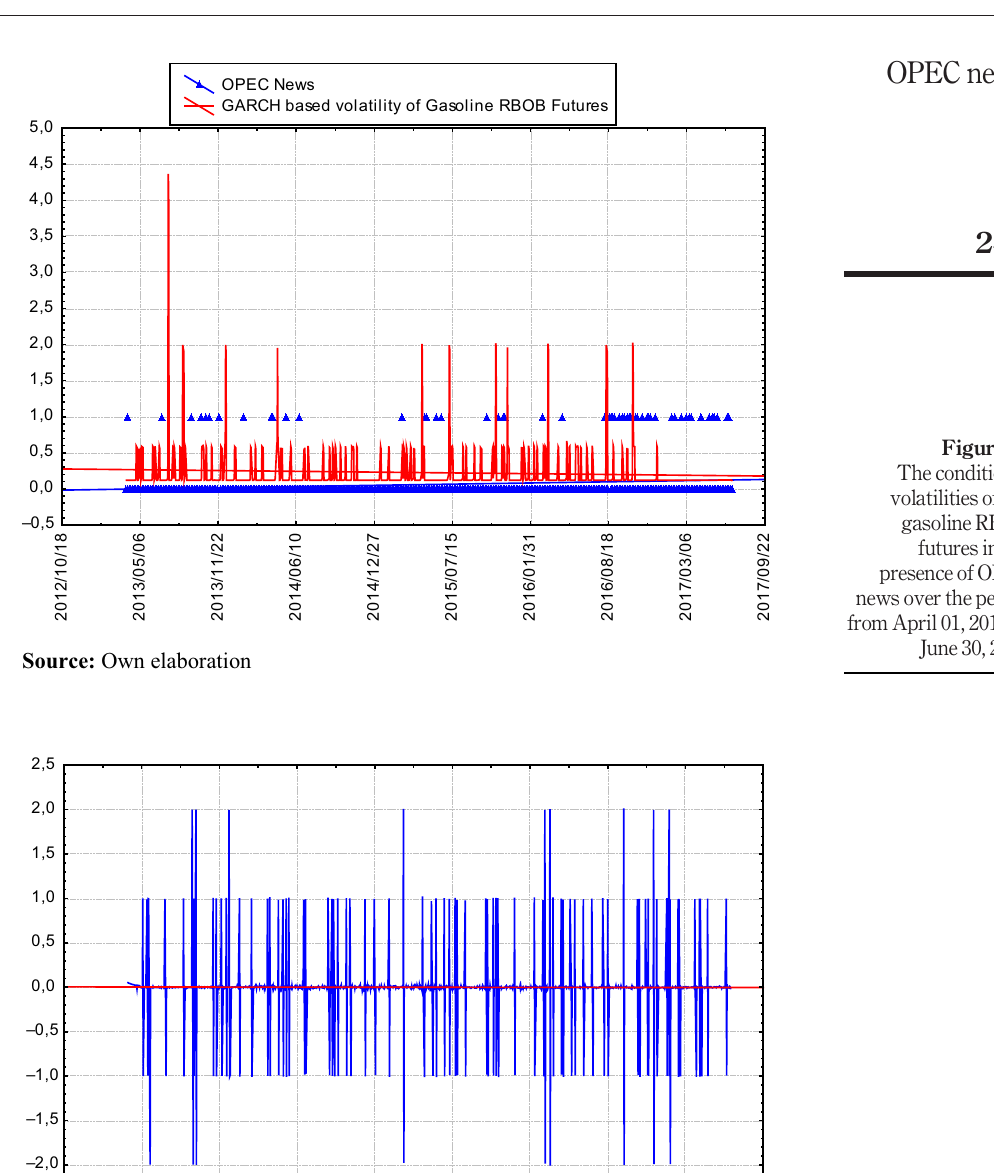
Figure 5. The return of the Brent oil futures over the period from